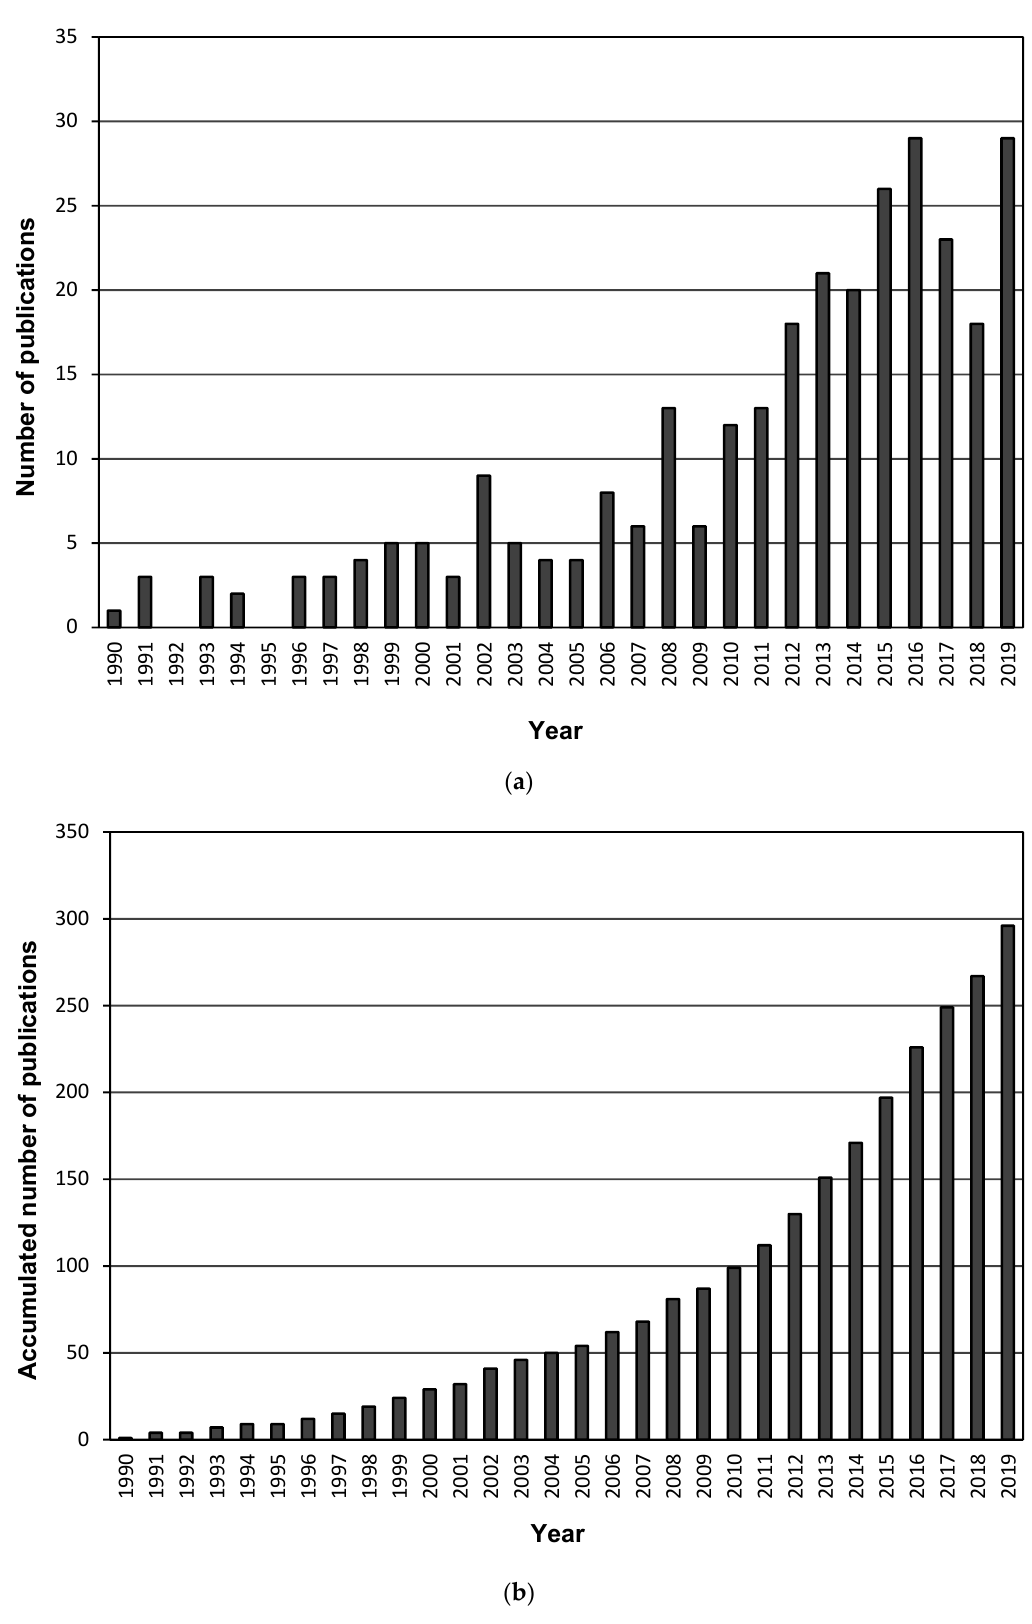
Figure 1. Annual ( a ) and accumulated ( b ) publication output.